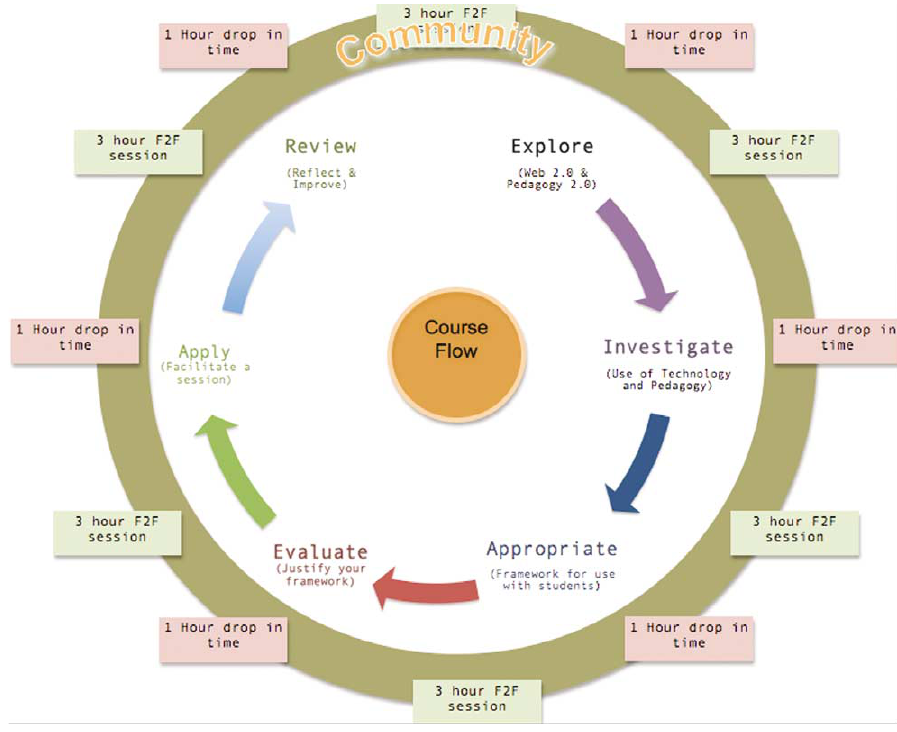
Figure 1. Outline of the SLT